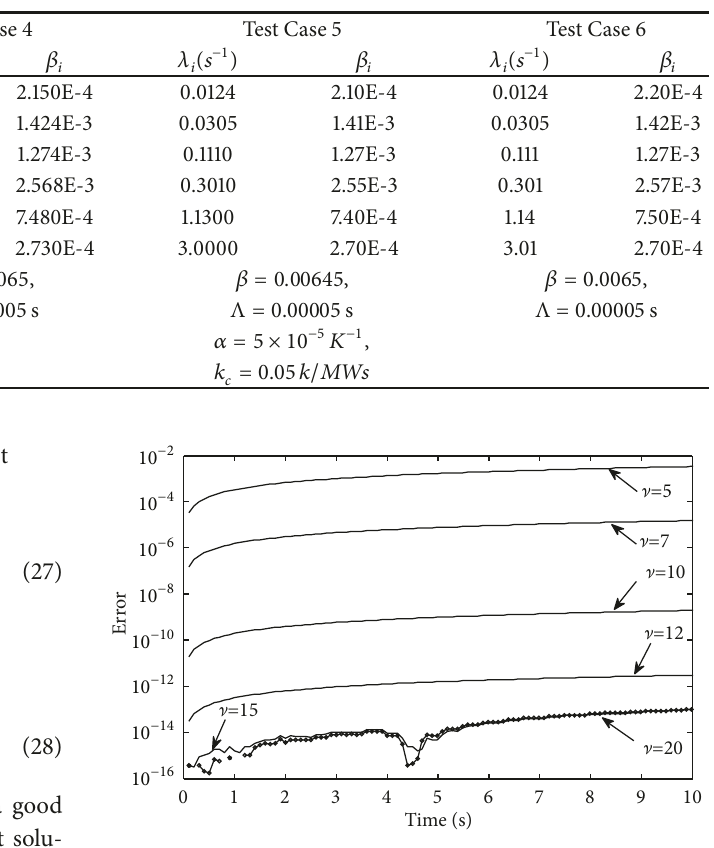
Figure1:Relativeerrorsassociatedwithdifferentmethodorders ] = 5,7, 10,12,15 , and 20 for the model problem using 𝜆 = −5 and ℎ = 0.1